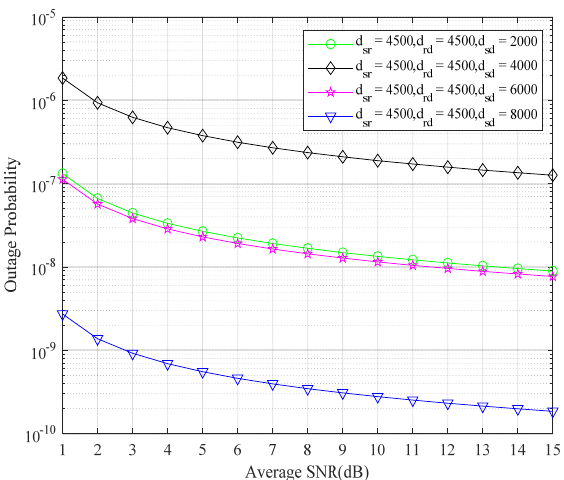
Figure 7. Outage probability of cooperative FSO communication system under different communication distances.